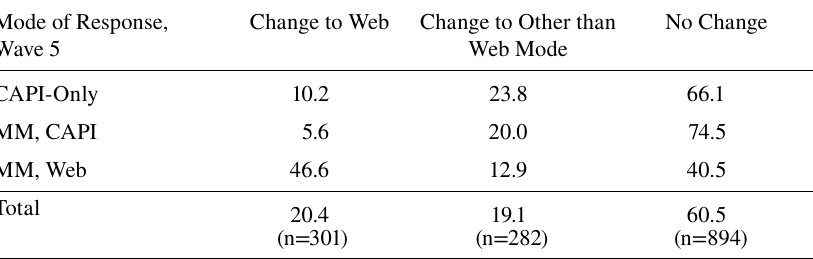
Percent Switching of Mode Preference by Mode of Response, Waves 4 to